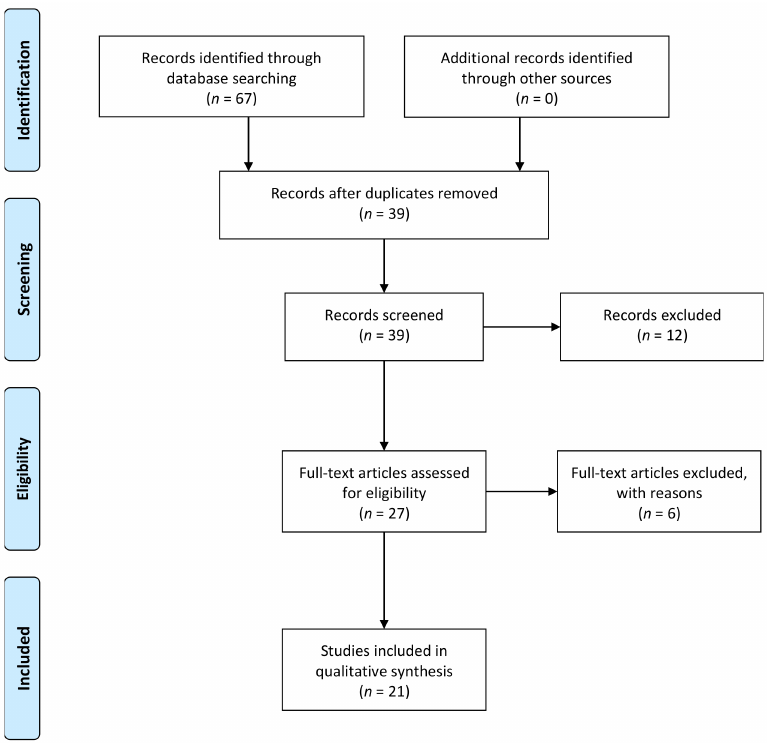
Figure 1. Flow diagram of the literature selection